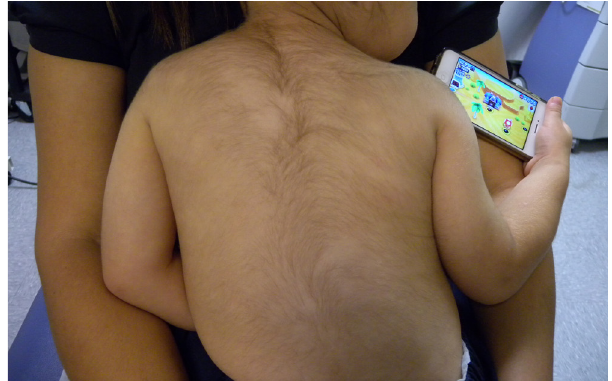
Figure 1. Note the augmented number and thickness of hairs in the back and face of this young child characterizing